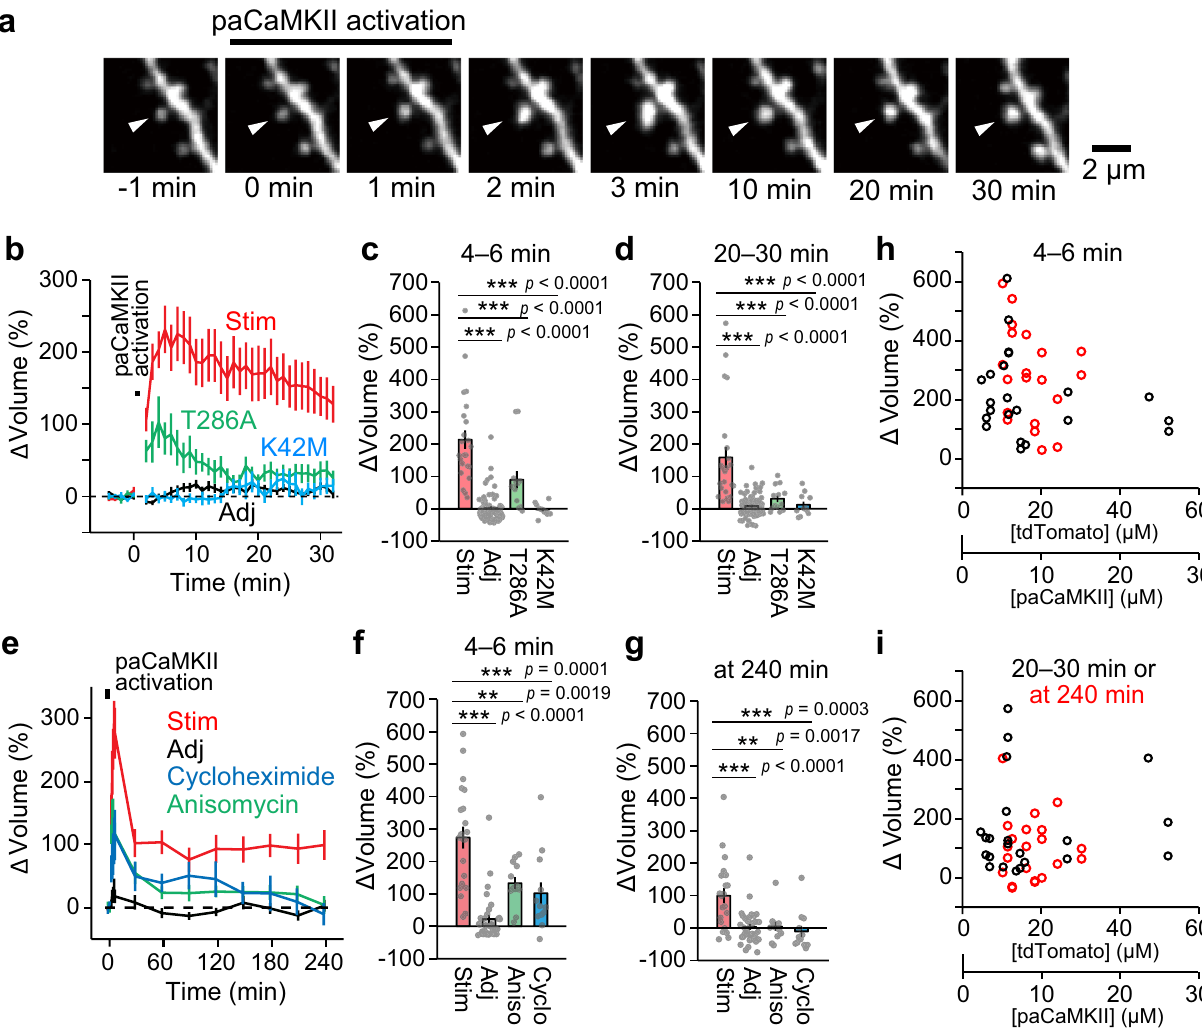
We used two-photon microscopy to measure the GCaMP6f fl uorescence in dendritic spines. We found that paCaMKII acti- vation in single spines induced no detectable Ca 2 + increase, but increased spine volume (Fig. 4a – c). In contrast, photorelease of